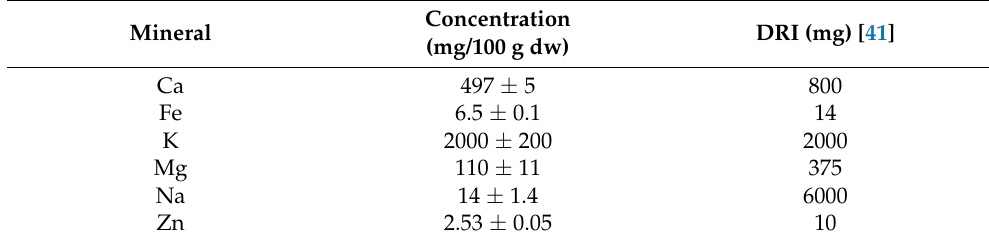
Table 1. Elderberry stalks’ essential minerals content and their respective dietary reference intakes